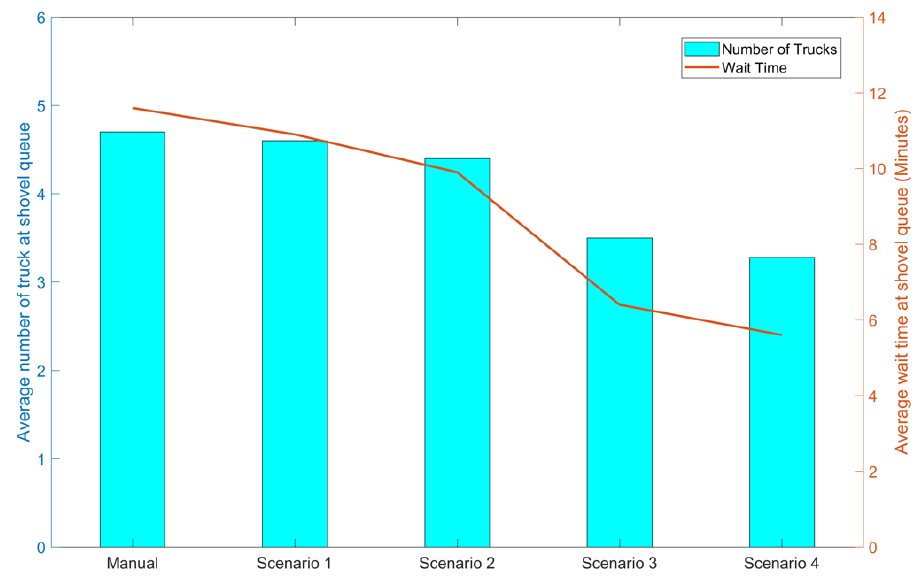
Figure 6. The average number of trucks in the queue and their wait time at loading locations.